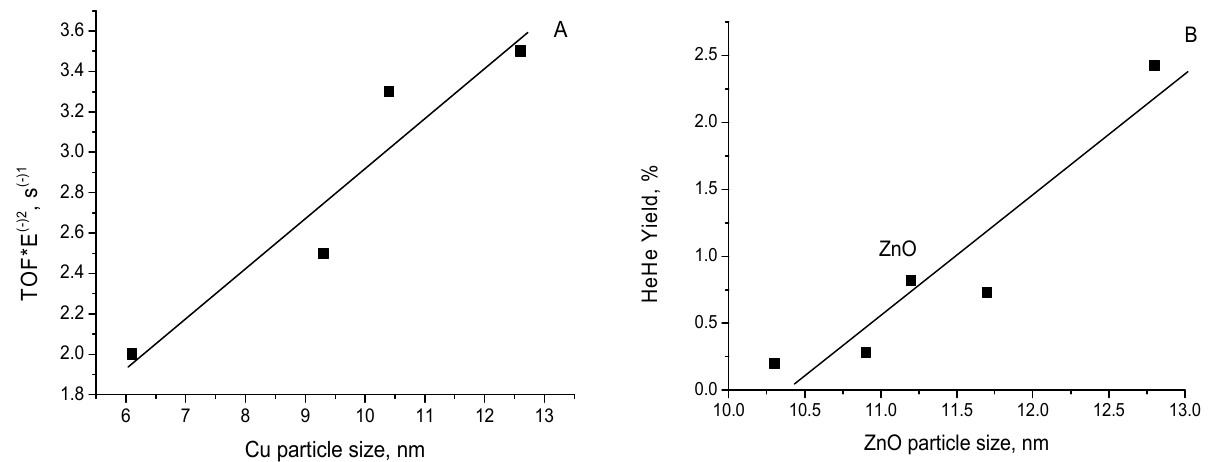
Figure 5. ( A ). The dependence of TOF in MeHe hydrogenolysis on the size of copper particles in reduced CuZn catalysts. ( B ). The dependence of HeHe yield in reaction between MeHe and 1-Heol on the size of ZnO particles in reduced CuZn catalysts and a single-phase ZnO.